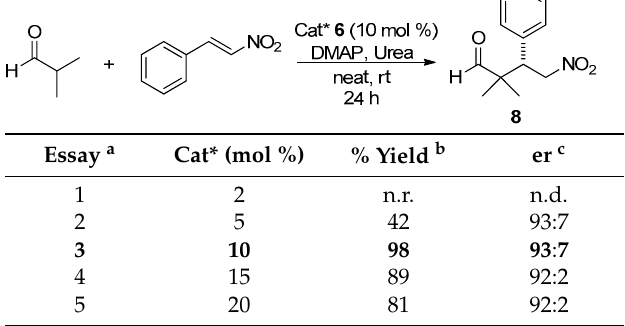
Table 6. Michael addition reaction of isobutyraldehyde to trans - β -nitrostyrene with different amounts of catalyst.